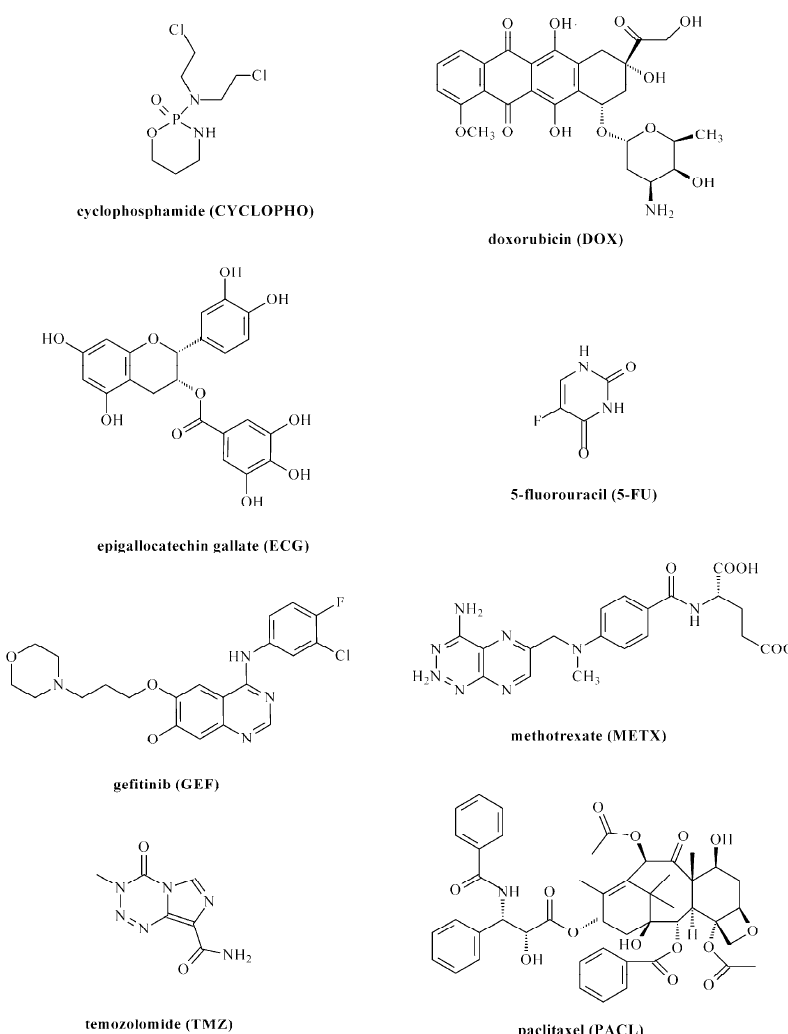
Figure 4. Anti-cancer drugs used in the technology for polyurethane drug delivery systems.